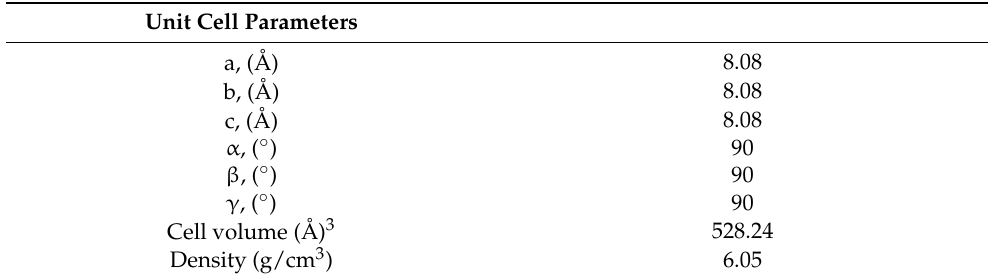
Table 1. Estimated lattice structure parameters and refinement parameter values from Rietveld refinement of Co 3 O 4 @Mo-Co 3 O 4 heterostructure.